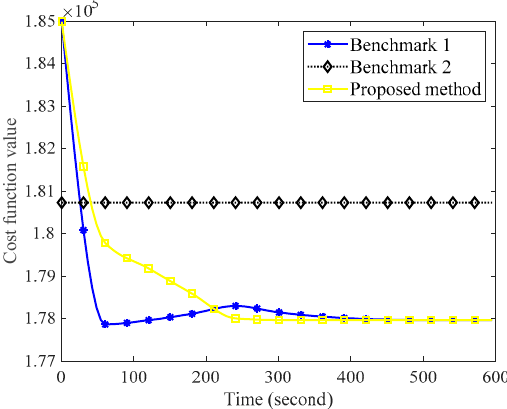
Figure 4. The total active injection of all 33-bus systems.